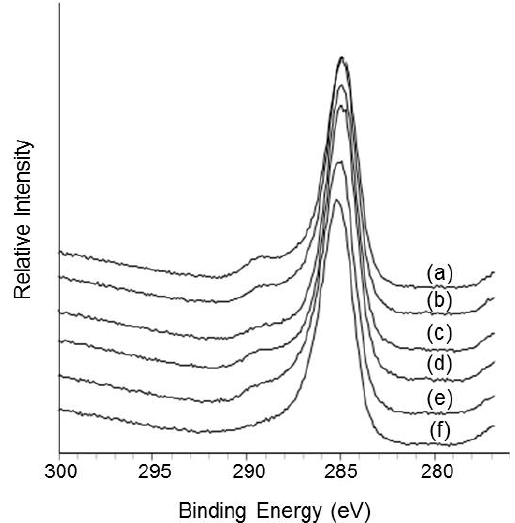
Figure 4. XPS C1s spectra of PLA fibers and CS fiber: ( a ) original PLA fiber; ( b ) P-2; ( c ) P-3; ( d ) P-4; ( e ) P-5, and ( f ) CS